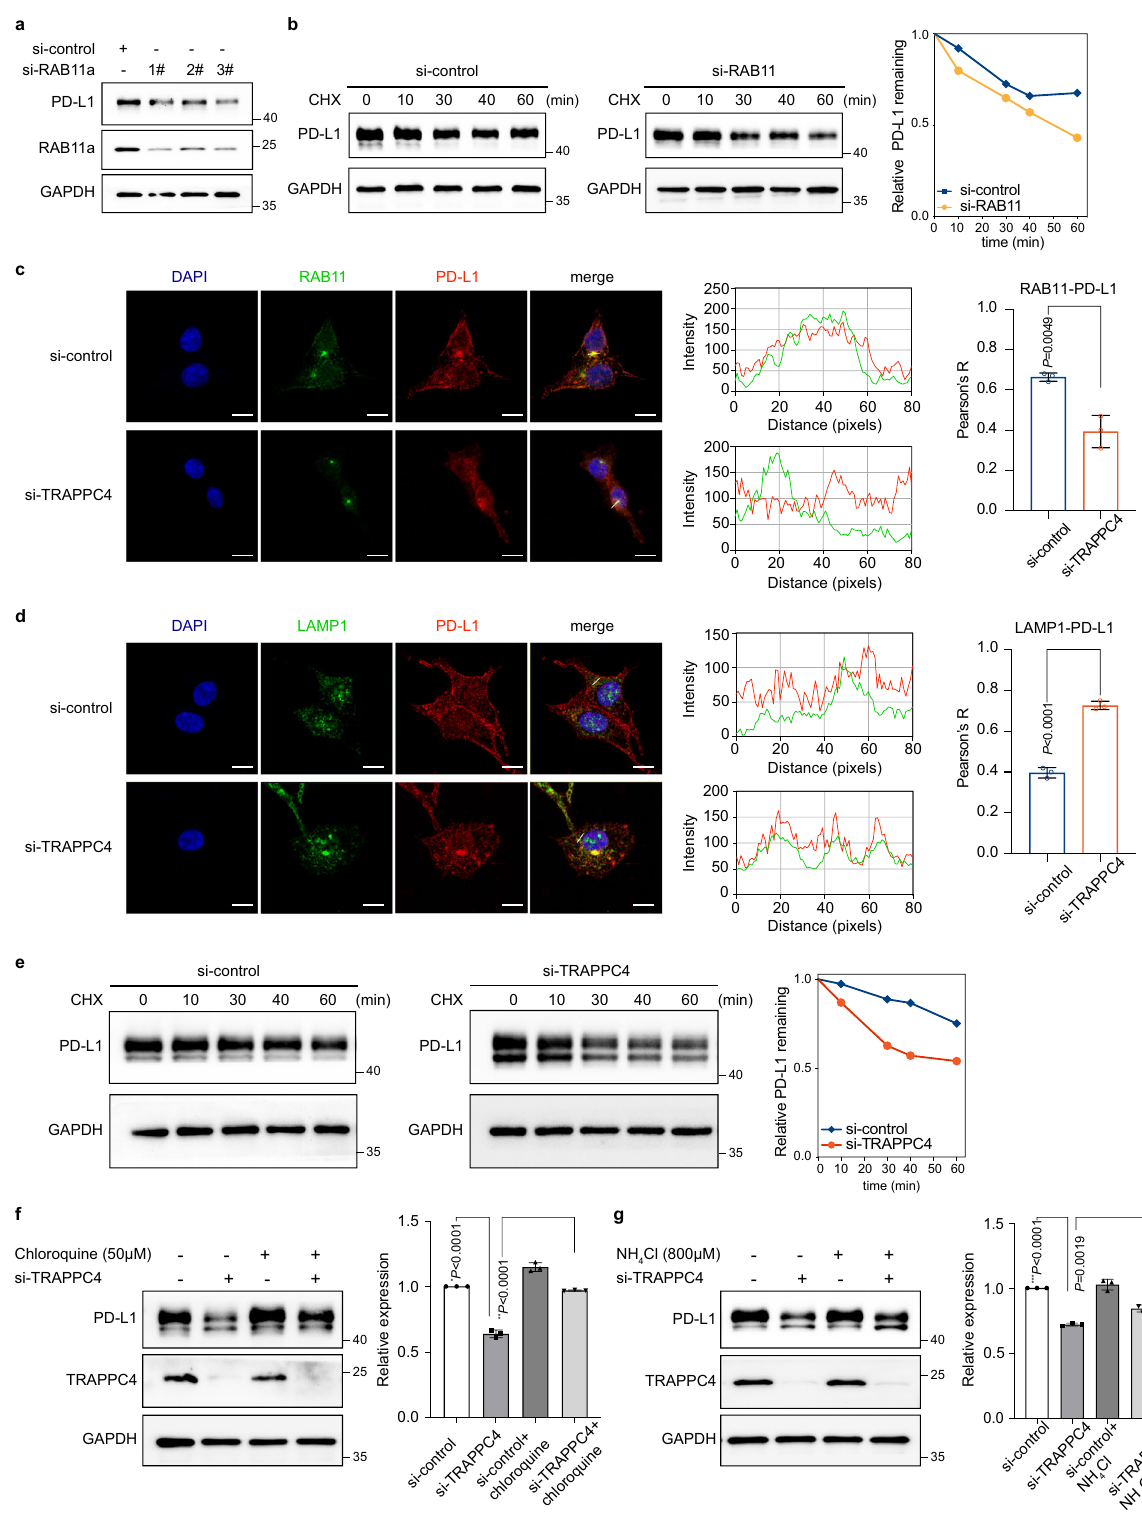
replenishing PD-L1 in the cell membrane and promoting immune evasion. The key role of TRAPPC4 in the regulation of PD-L1 adds another piece of crucial information concerning the spatial transportation of PD-L1. The fi nding that Trappc4- OE MC38 tumors were more sensitive to ICB makes a potential case for TRAPPC4 as a therapeutic target and predictor of the response to ICB. NATURE COMMUNICATIONS| (2021) 12:5405